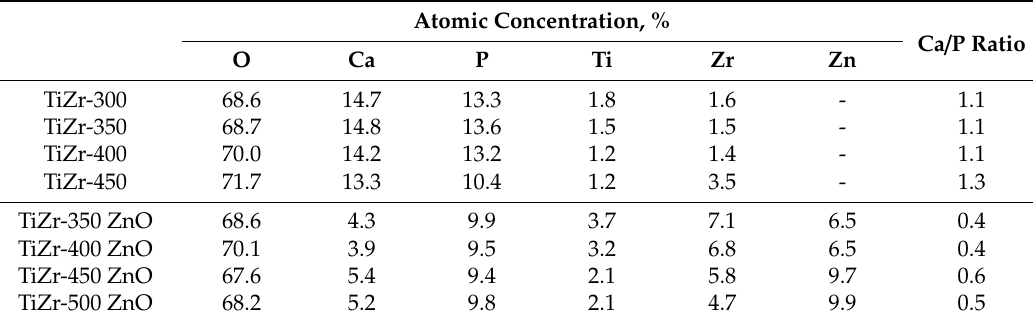
Table 1. The semi-quantitative EDX analysis of PEO coatings. Atomic Concentration,